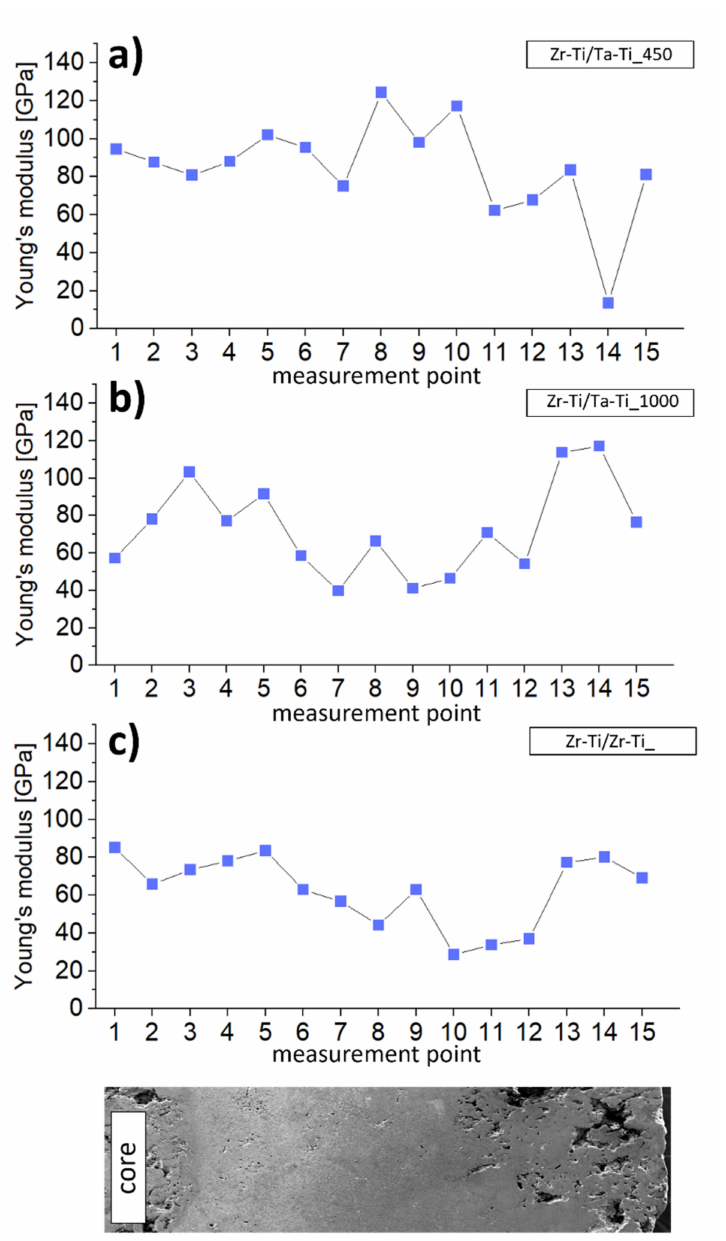
Figure 8. The relationship between the Young’s modulus and measurement location (from core to outside zone of sample, representation at the bottom) for samples ( a ) Zr-Ti/Ta-Ti450, ( b ) Zr-Ti/Ta- Ti1000, ( c )